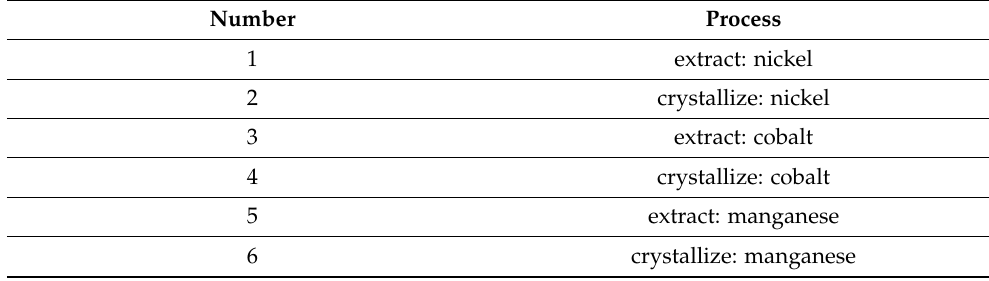
Table A20. Activities of the main application process “recycling”: recovery of nickel, cobalt, and manganese.